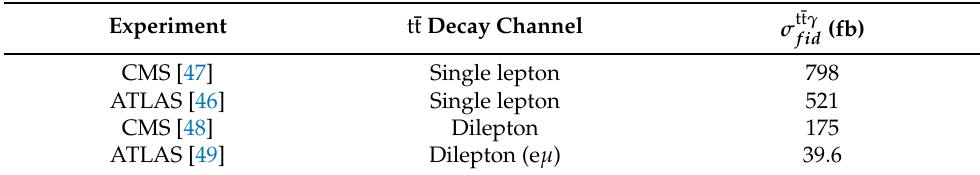
Table 2. Table of the inclusive t¯t γ production fiducial cross-section measurements from ATLAS and CMS.